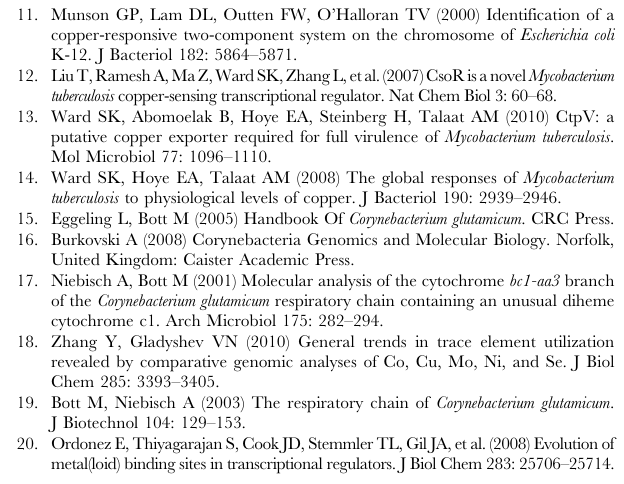
Figure S1 EMSAs for testing the binding of CopR. The binding of CopR to the promoter regions of putative target genes